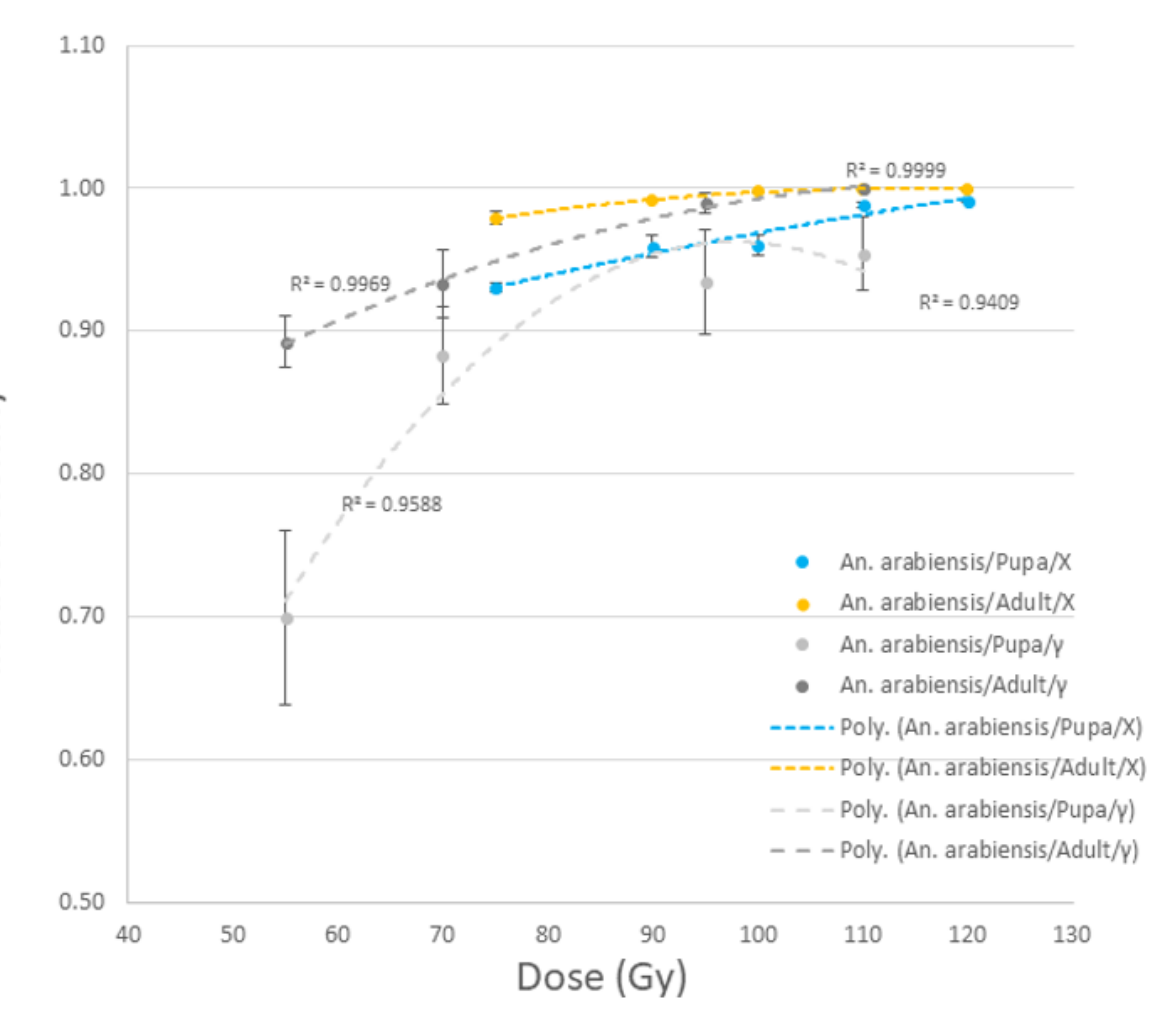
Figure 5. Dose response data of An. arabiensis male pupae and adults irradiated with MK2 (X-ray) irradiator compared to the same strain irradiated in GC220 irradiator (gamma ray).